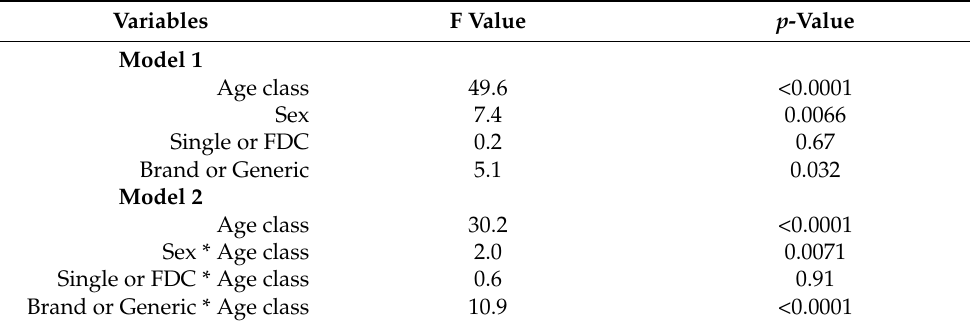
Table 3. Multivariate analysis by mixed-effect regression models.